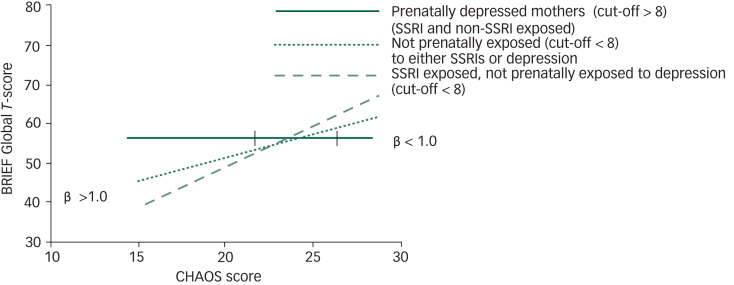
Confirmatory model with the best fit (differential susceptibility strong model) (refer to Table 4).